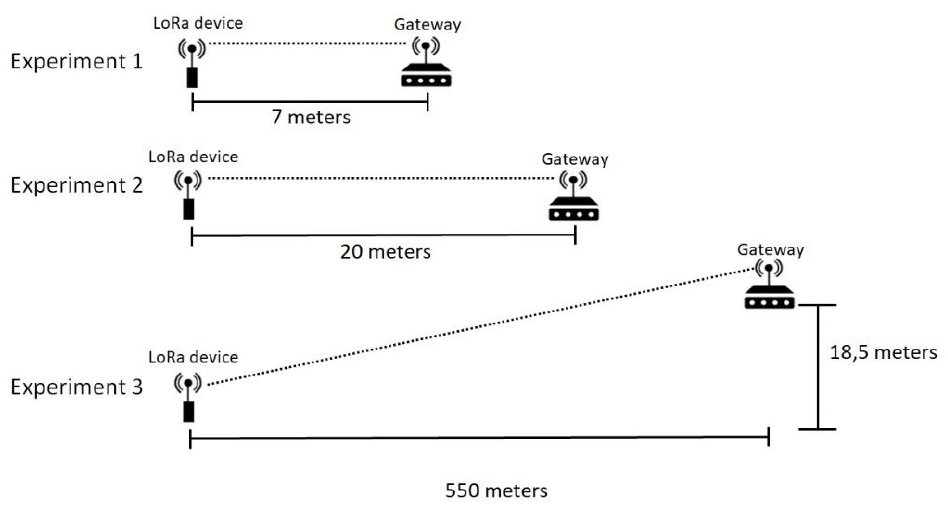
Figure 3. Distances and device locations in the three initial experiments (with fixed distances).